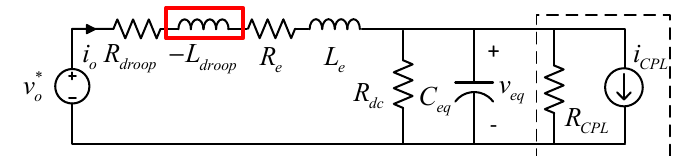
Figure 4. Simplified circuit diagram of the VNI stabilizing strategy controlled dc microgrid system.